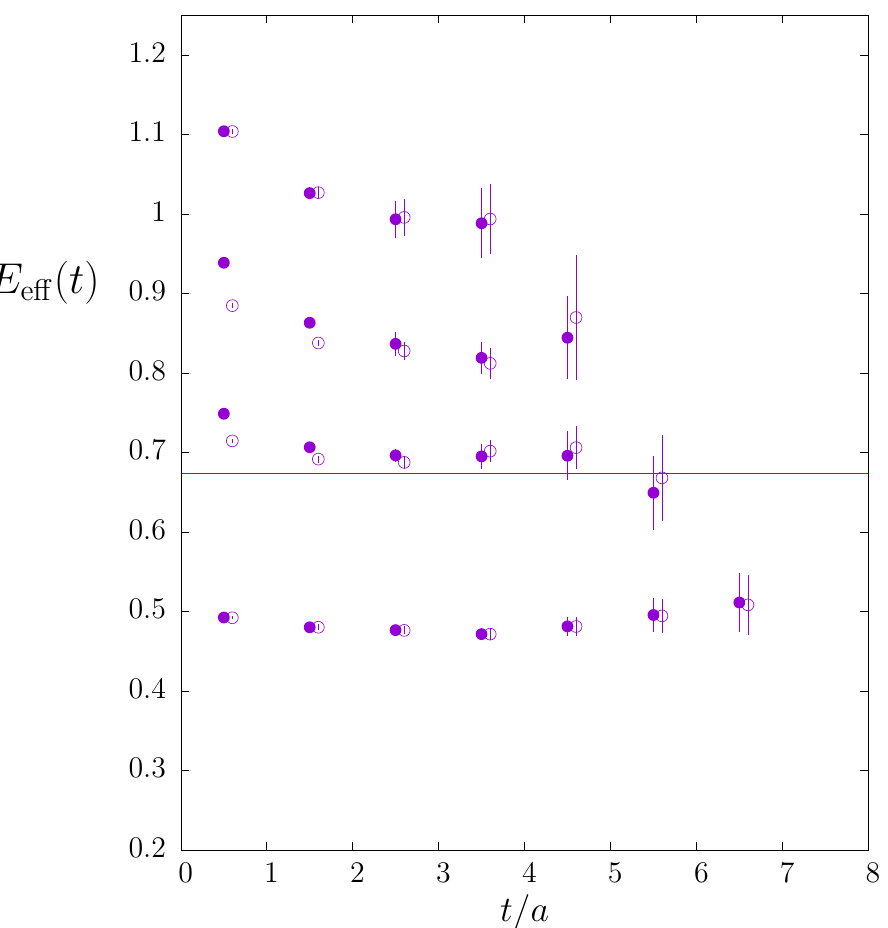
Figure 3 . Effective energies of the lightest A 1 ++ states from the basis of the usual single loop operators, • , and from the same basis but extended with our ditorelon operators, ◦ . Horizontal line is the energy of the lightest ditorelon state neglecting interactions between the torelons. On a 18 3 26 lattice at β = 6 . 235